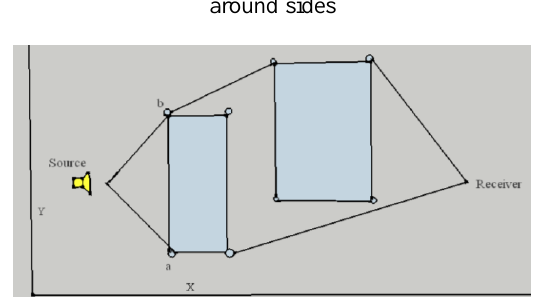
Figure 9. Determination of principal paths around sides